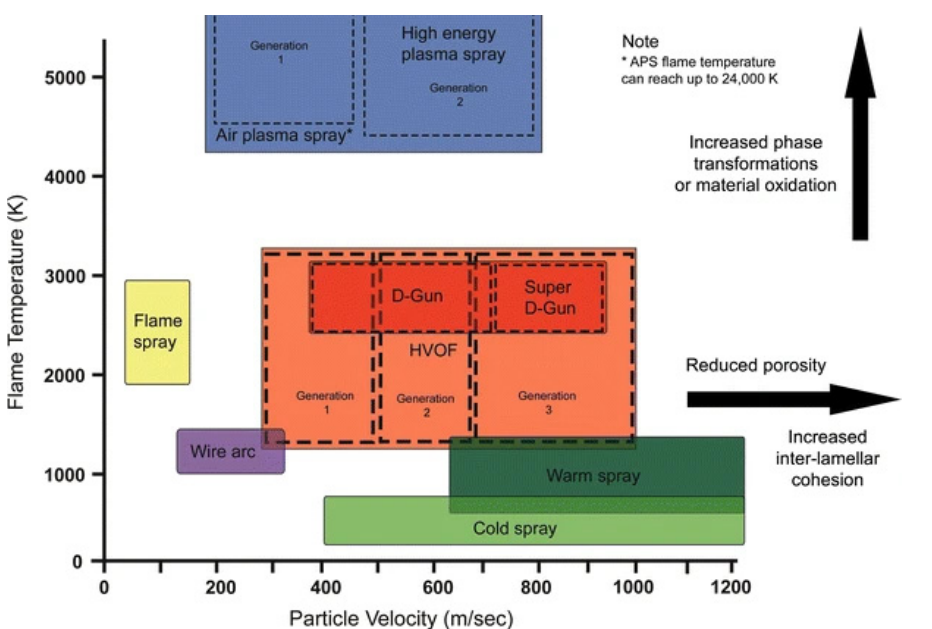
Figure 3. Temperature and velocity profiles of thermal and cold-spray technologies [47].